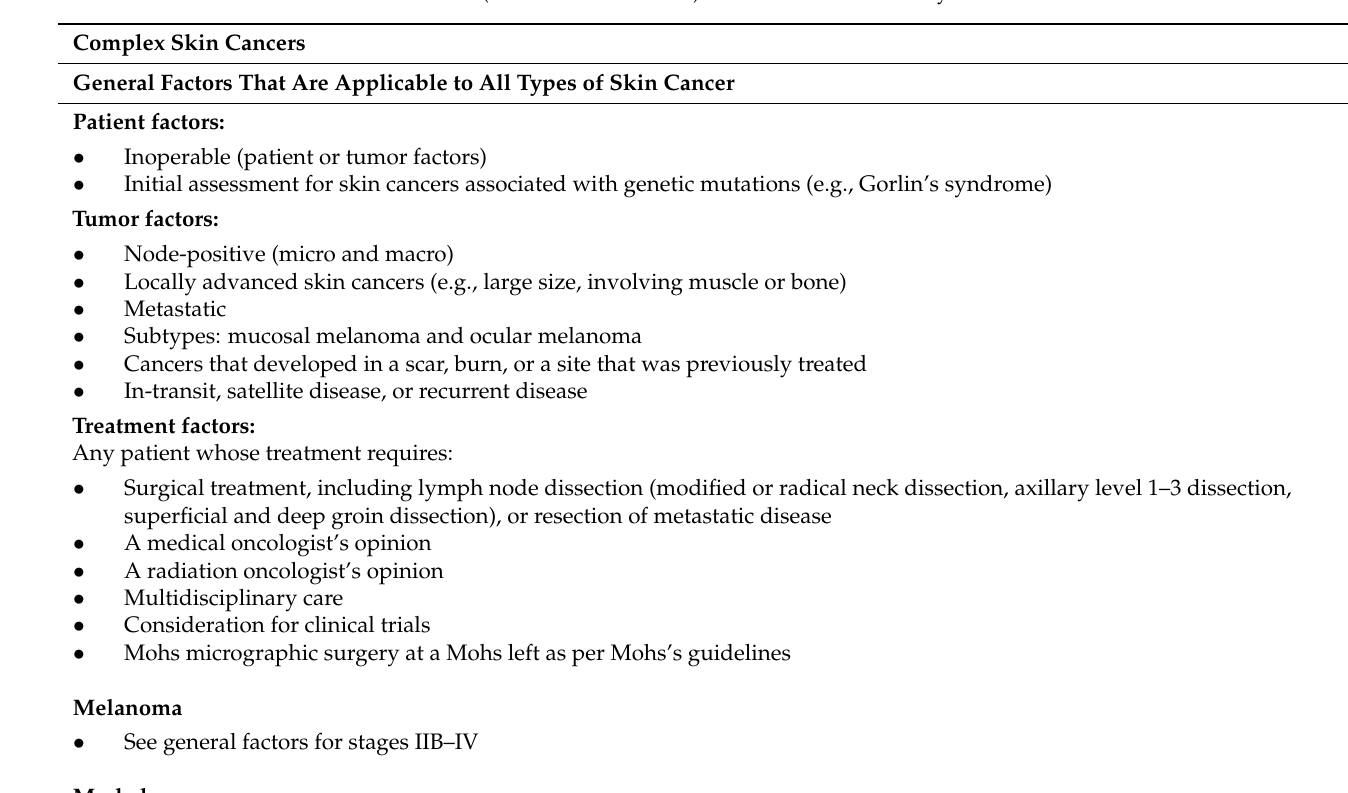
Table 1. Ontario Health (Cancer Care Ontario)’s Skin Cancers Advisory Committee